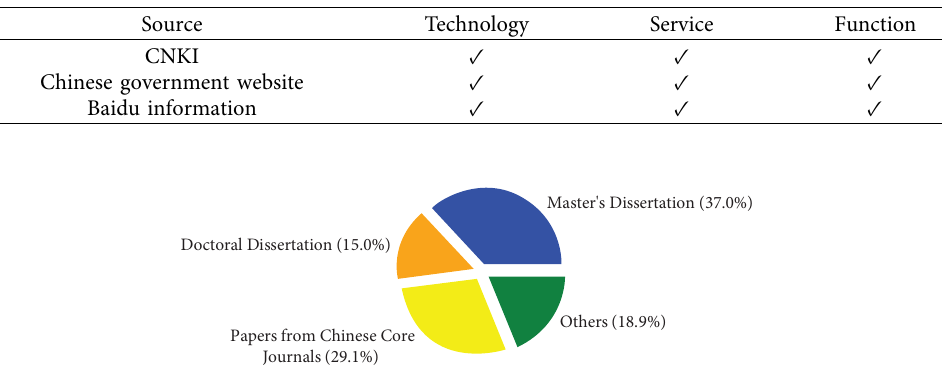
Figure 4: In order to ensure the quality of papers, when collecting data, doctoral dissertations, Master’s dissertations, and papers from Chinese core journals need to account for the majority.